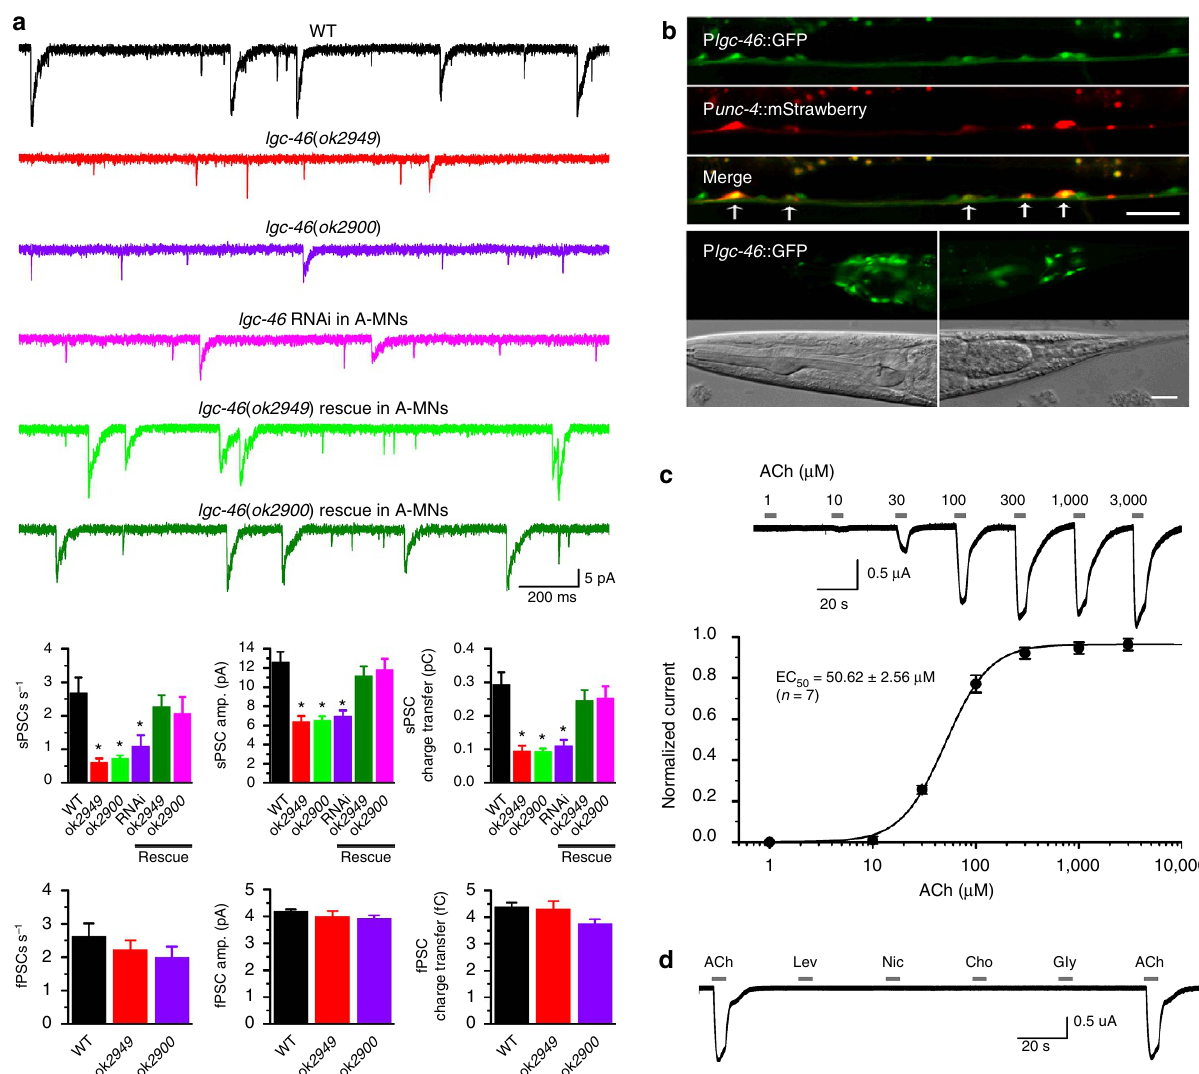
Figure 4 | Slow postsynaptic currents (sPSCs) but not fast PSCs (fSPCs) in VA5 result from the activation of an LGC-46 acetylcholine receptor. ( a ) Sample traces and statistical comparisons of spontaneous PSCs among wild type (WT) ( n ¼ 11), lgc-46(ok2949) ( n ¼ 11), lgc-46(ok2900) ( n ¼ 6), lgc-46 knockdown (RNAi) specifically in A-type cholinergic motor neurons (A-MNs) ( n ¼ 11), and the two mutants rescued by expressing wild-type LGC-46 specifically in A-MNs ( n ¼ 10 ok2949 ; n ¼ 7 ok2900 ). The asterisk (*) indicates a statistically significant difference compared with WT ( P o 0.05, one-way ANOVA with Tukey’s post hoc test). ok2949 and ok2900 are deletion mutants involving one or two exons (www.wormbase.org). ( b ) In a strain coexpressing GFP under the control of lgc-46 promoter and mStrawberry under the control of unc-4 promoter, all A-type cholinergic motor neurons are colabelled by the two fluorescent proteins (top three panels). The smaller fluorescent puncta (mostly away from the ventral nerve cord) are due to autofluorescence from the gut. GFP is also expressed in many neurons in the head and tail (bottom panels). Scale bar, 20 m m. ( c ) A sample trace showing whole-cell current of an oocyte in response to increasing concentrations of acetylcholine (top), and normalized acetylcholine concentration-response curve (bottom). Data are shown as mean ± s.e. ( d ) A sample trace showing that inward current is induced by acetylcholine but not by levamisole, nicotine, choline, or glycine (all at 100 m M). Holding voltage was (cid:2) 60mV in all